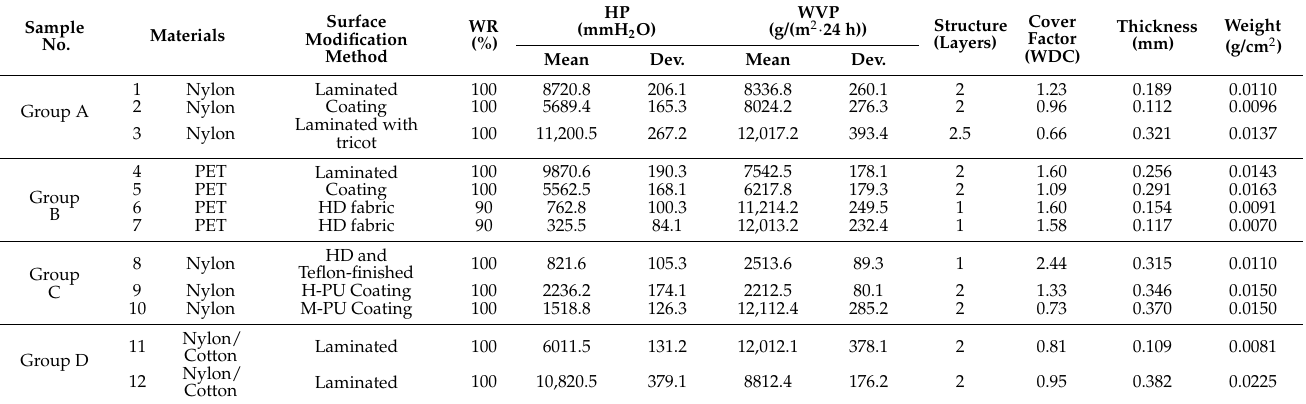
Table 2. Specimens according to materials and surface modification method.